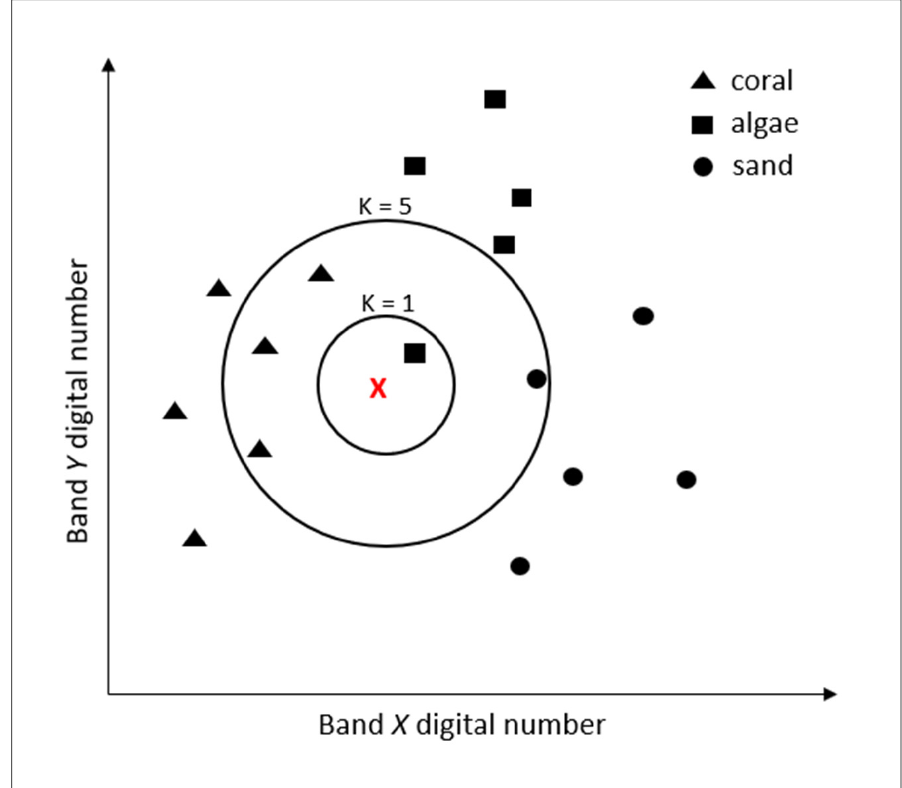
Figure 4. Basic conceptualisation of k nearest neighbour classification illustrating 3 classes. Circles show the class when k = 1 and when k = 5.